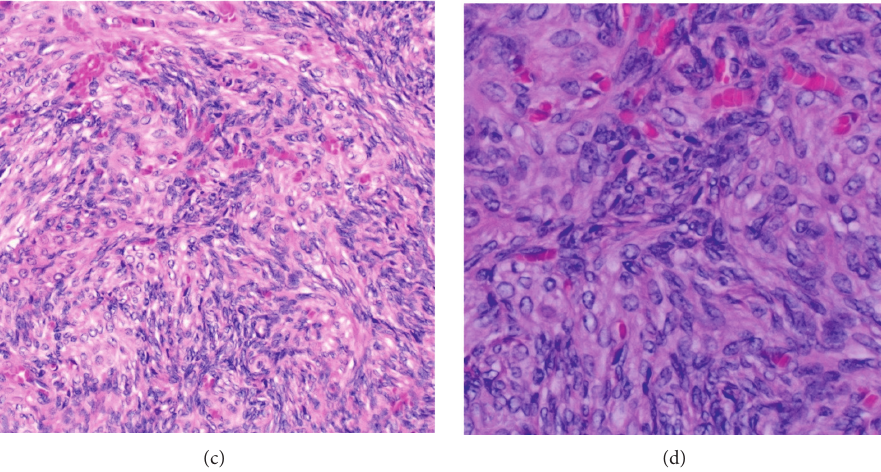
Figure 2: Microscopic images depicting ovarian hyperthecosis with stromal hyperplasia and abundant spindled theca cells. Corpora albicantia (B) was also apparent throughout the specimen. Hematoxylin and eosin stain, original magnification: (a) 4x, (b) 4x, (c) 20x, and (d) 40x. Table 1: Pre and postbilateral oophorectomy laboratory results for case 1 and case 2. Case 1: pre and postsurgery